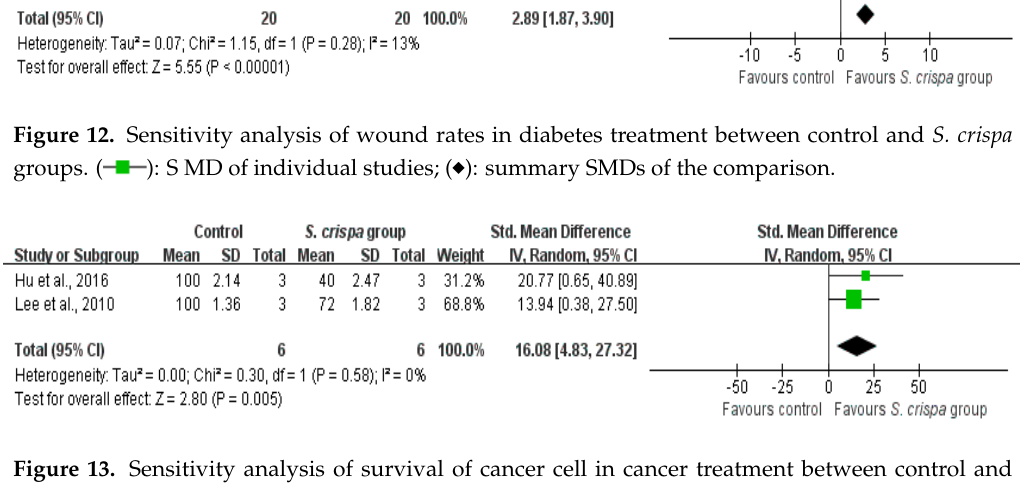
Figure 5. Comparison of levels of tumor activity between control and S. crispa groups. ( individual studies; (  ): summary SMDs of the comparison. Figure 10. Comparison of oxidative inhibitory capacity between control and S. crispa groups. (